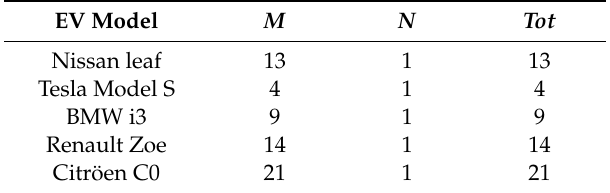
Table 7. Sizing of shared I-Life ESS for CSs by using di ff erent battery packs.